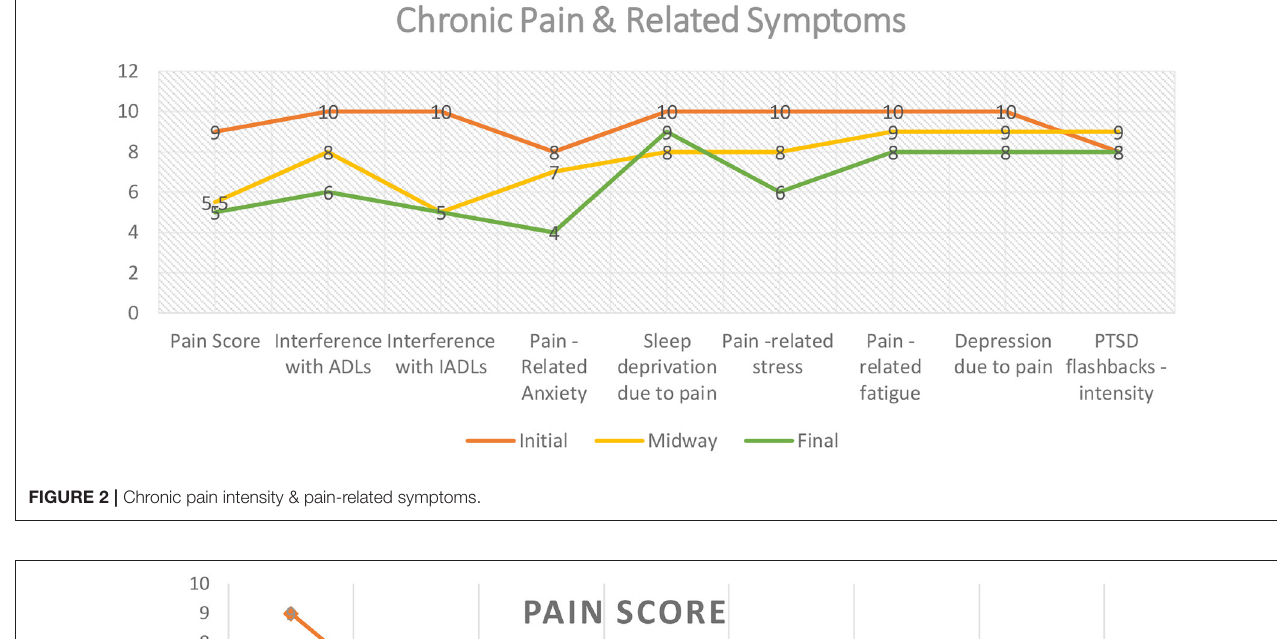
FIGURE 2 | Chronic pain intensity & pain-related symptoms.